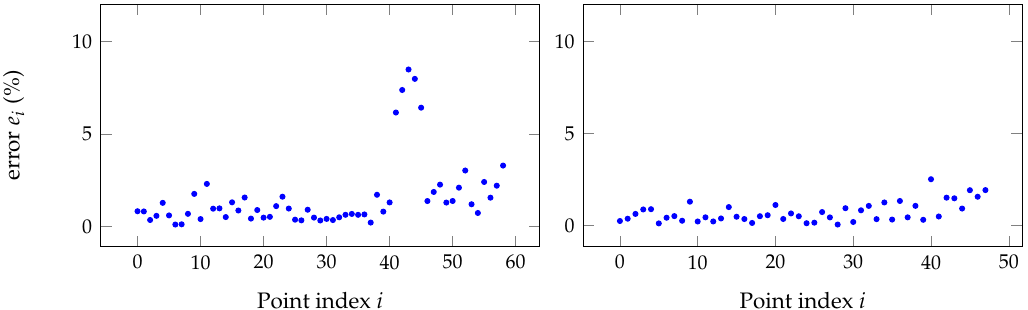
Figure 9. Percentage of error between each point of one point cloud with another point cloud before ( left ) and after ( right ) the application of Chauvenet criterion for outliers